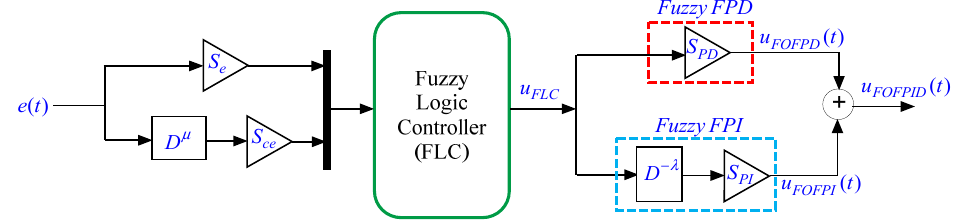
Figure 2. Detailed configuration of the FOFPID controller.